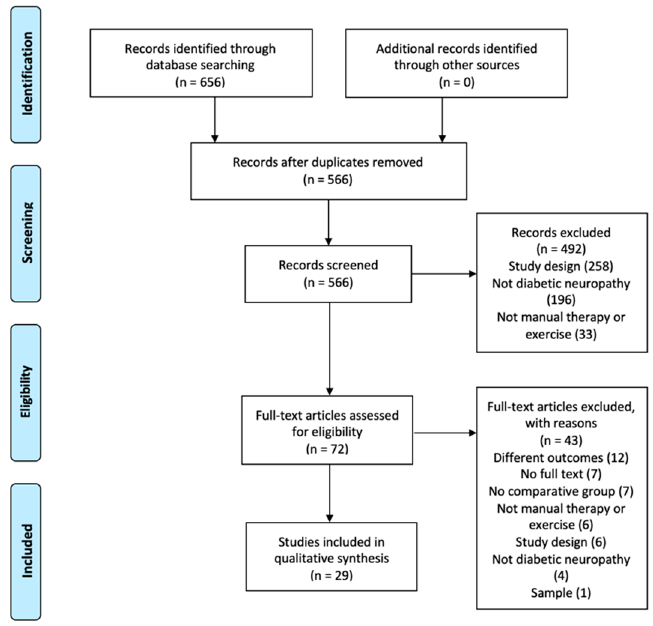
Figure 1. Flow diagram.